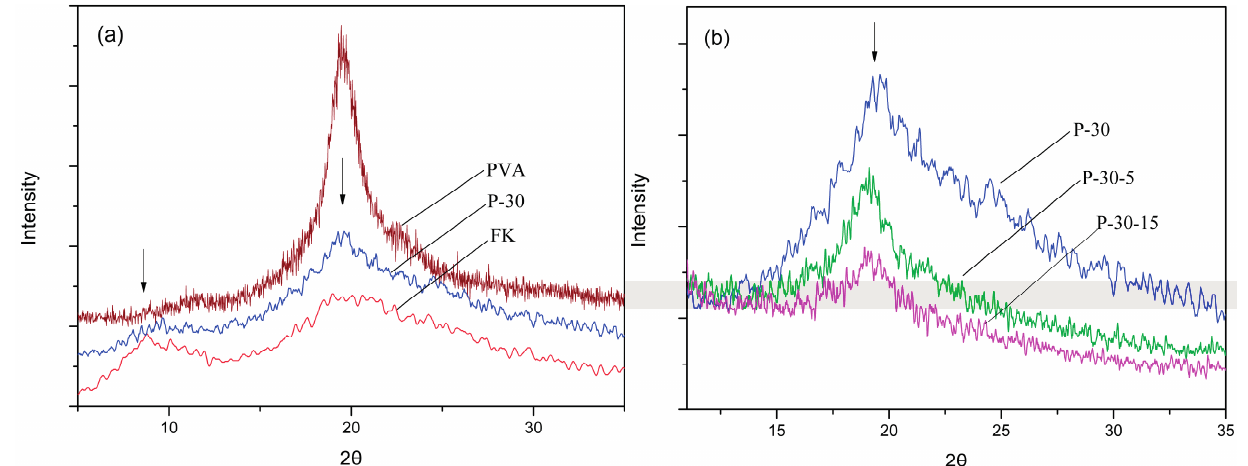
Figure 2. XRD patterns obtained for ( a ) pure PVA and pure FK, and ( b ) the blend films P-30, P-30-5, and